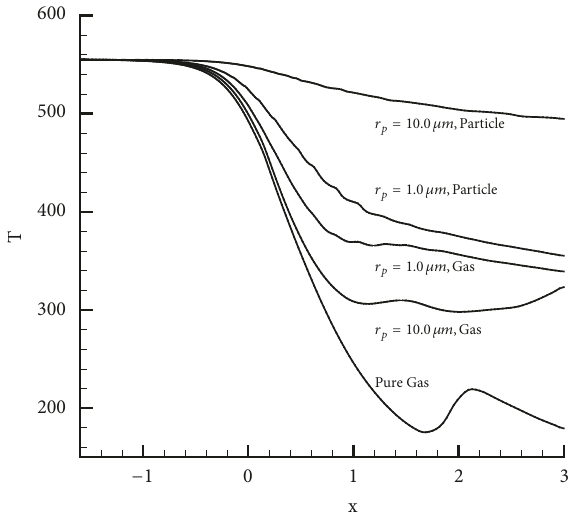
Figure 7: Temperature profiles along centerline.